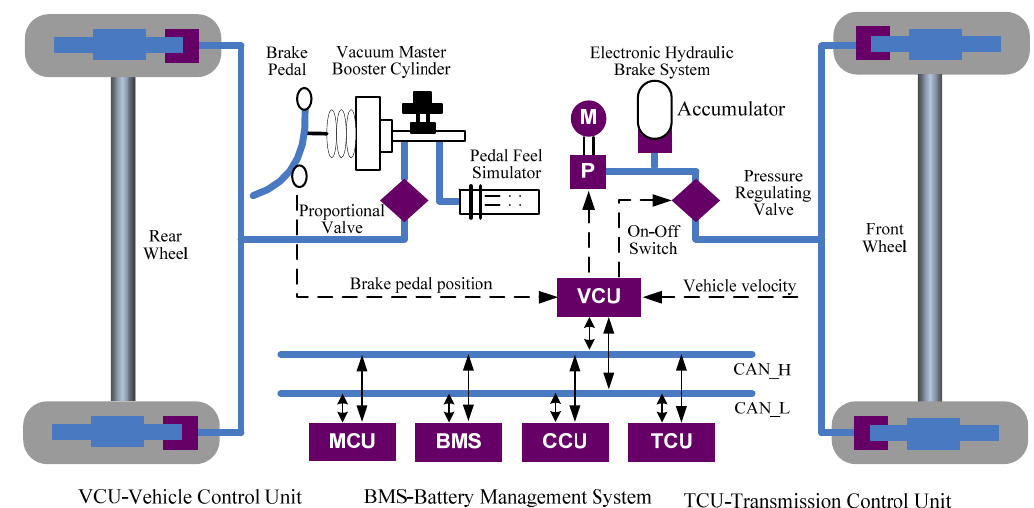
Figure 2. Brake system of the LF620